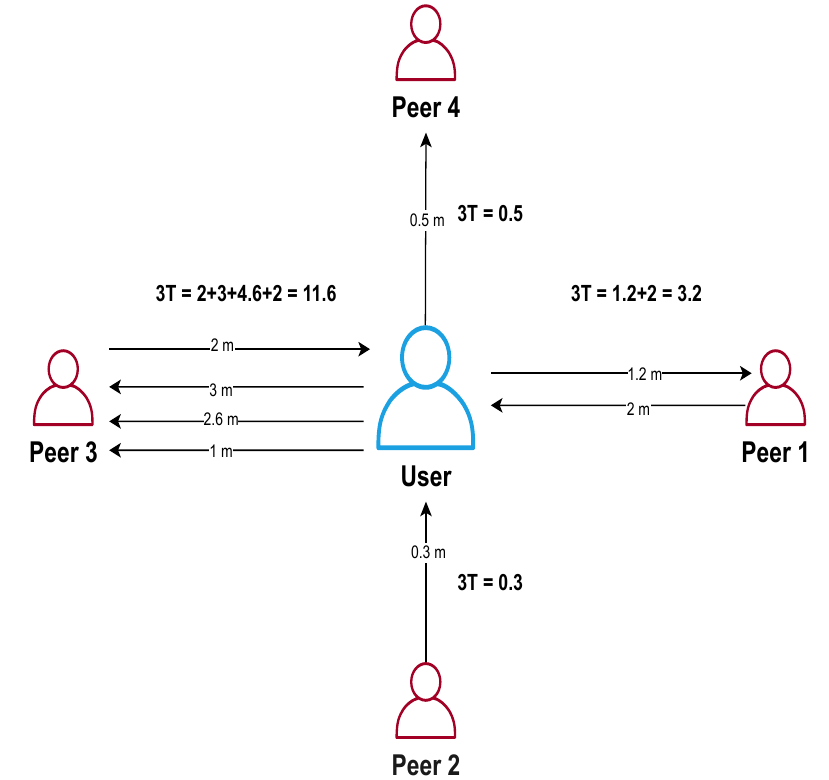
Figure 6. Caller neighbourhood in communication